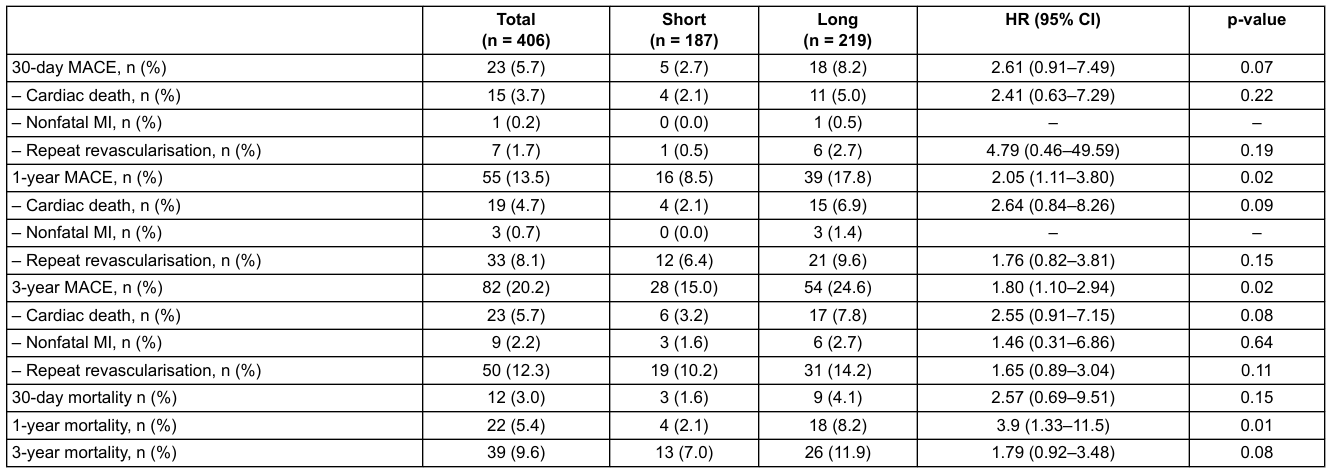
Table 3: Primary clinical end point and overall mortality at 30 days, 1 year and 3 years according to treatment delay.